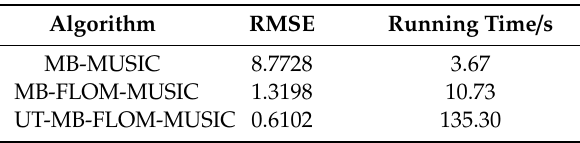
Table 2. Running Time (CT model).